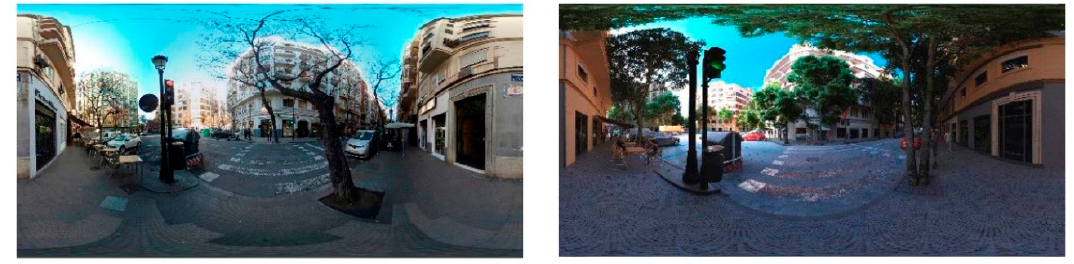
Figure 2. Comparison of the physical scenario (left) and its virtual replica (right; parameterization of urban design variable (PUDV) # B).